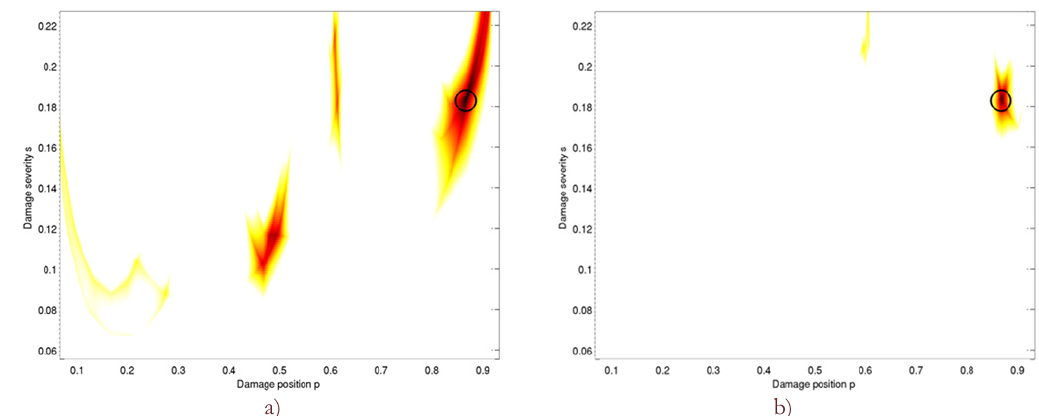
Figure 9: Nonlinear harmonic identification on a spanned beam with damage p =0.85, s =0.18 excited at l F / l =0.5. a) Three mode identification; b) Four mode